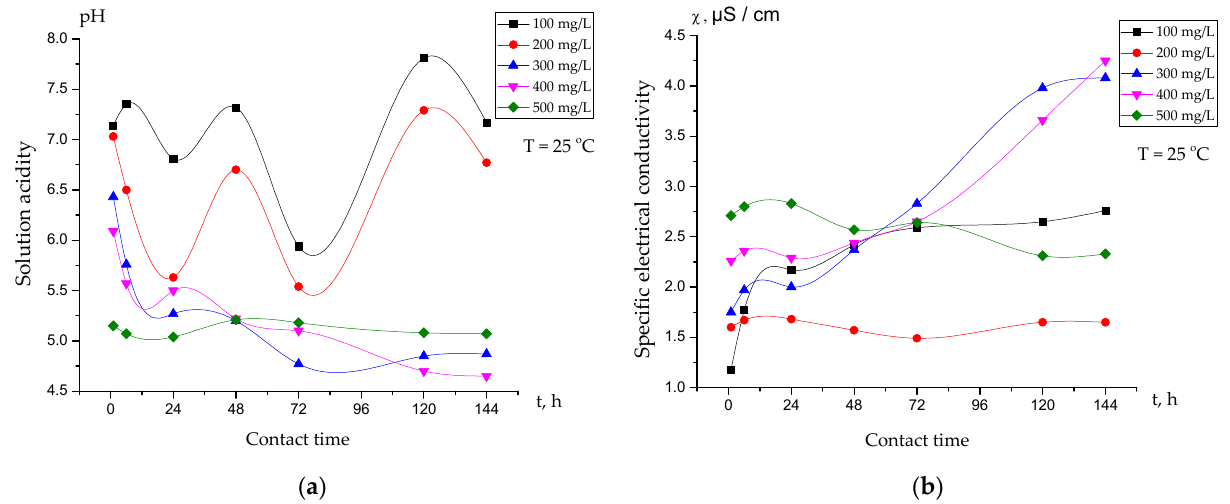
Figure 2. ( a ) Dependence of pH on the mass concentrations of Amberlite IR120 and AV-17-8 (3:3) in solutions as a function of time; ( b ) dependence of specific electrical conductivity ( χ ) on the mass concentrations of Amberlite IR120 and AV-17-8 (3:3) in solutions as a function of time.